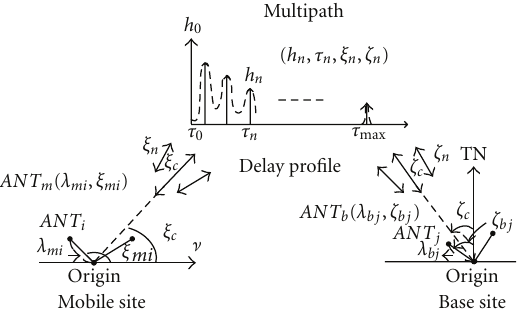
Figure 1: MIMO channel